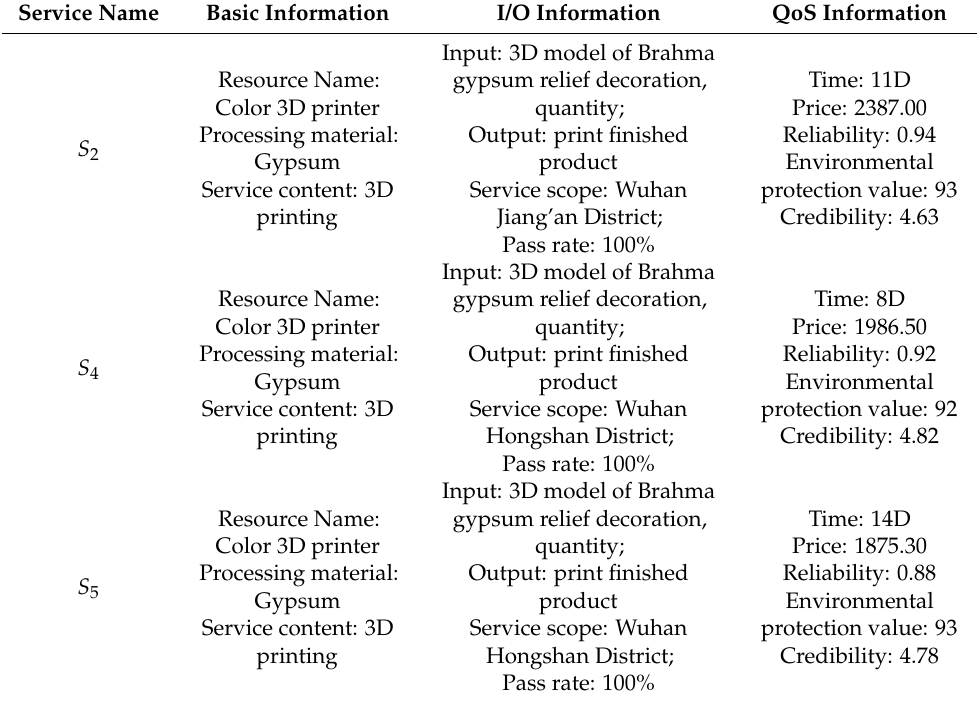
Table 4. The list of candidate 3D printing resource